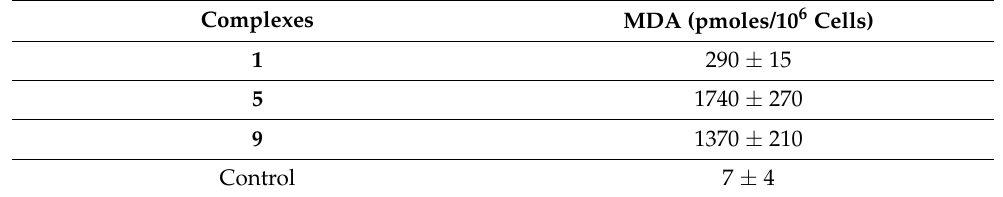
Table 2. Lipid peroxide (MDA) content in the OVCAR3 cells treated for 6 h with 1 , 5 , and 9 at 100, 50, and 20 µ M, respectively. Results are the mean ±